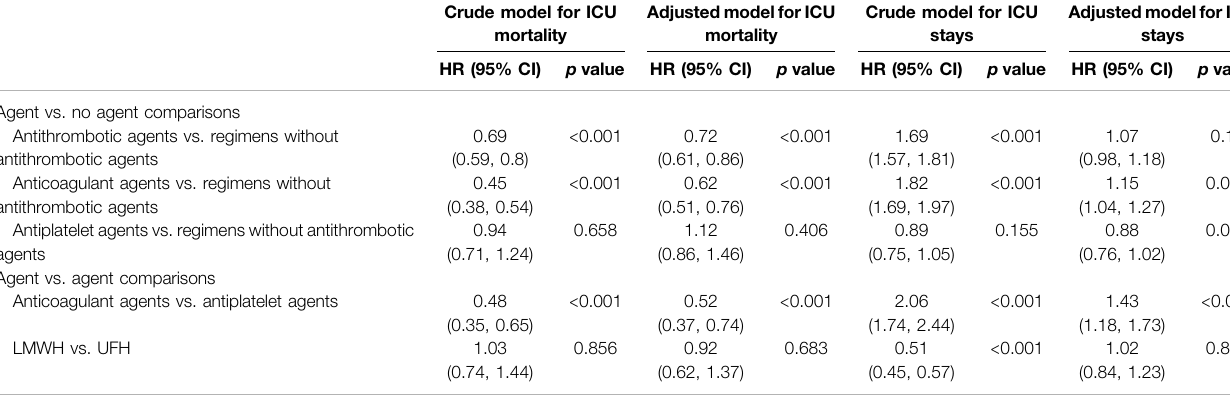
TABLE 4 | Association between antithrombotic agents and patient outcomes.